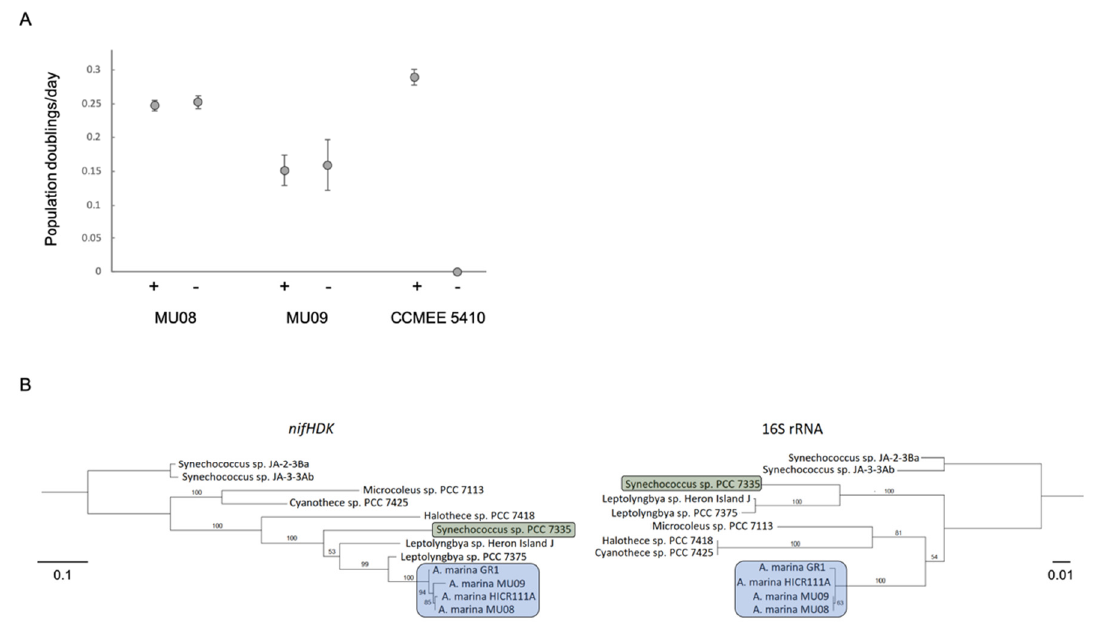
Figure 4. ( A ). Population growth rate in the presence (+) or absence ( − ) of combined nitrogen for nif -containing strains MU08 and MU09 and for nif -lacking strain CCMEE 5410. Error bars are standard errors. ( B ). Maximum likelihood phylogenies for nifHDK and 16S rRNA genes reconstructed with a GTR+I+G model. Bootstrap support values greater than 50% are shown for 1000 bootstrap replicates. Branch lengths are in units of expected number of nucleotide substitutions per site. The two topologies were significantly different by an SH test ( p <